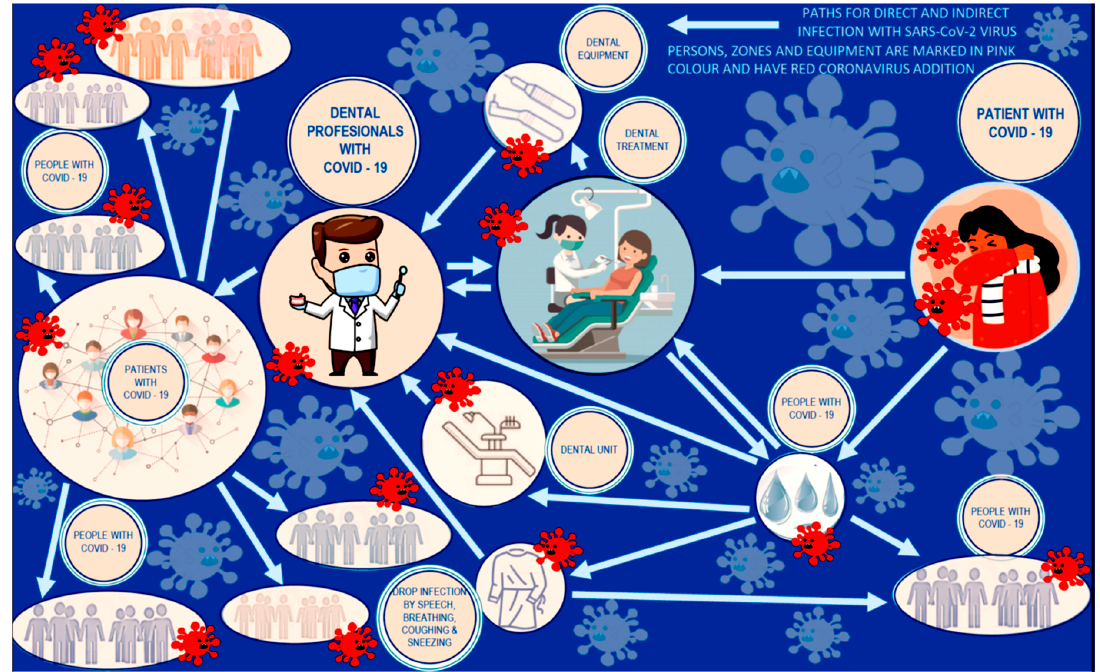
Figure 6. The mechanism of transmission of coronavirus infection by a dentist during a week of asymptomatic infection.